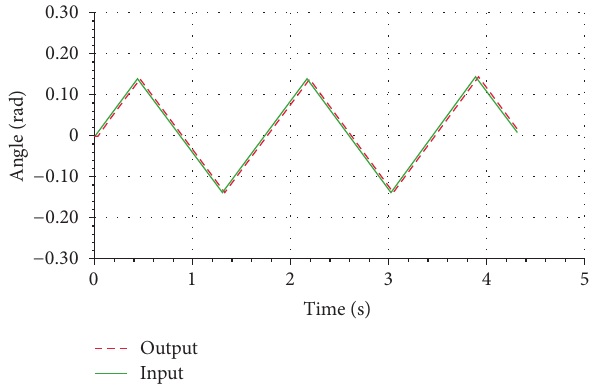
Figure 18: The relationship curve of input and output of steer angle changing with time under the steering speed 17 ∘